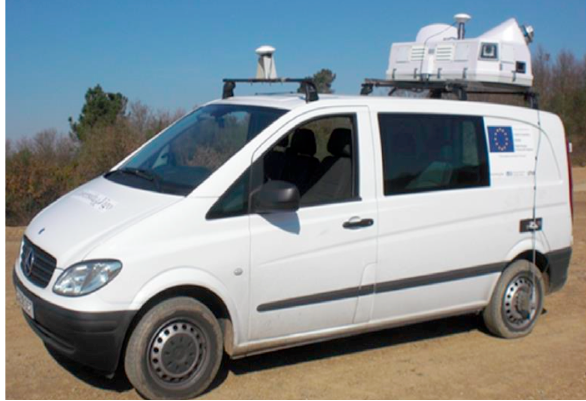
Figure 10. Optech Lynx mobile mapper. Draw (right) and survey van